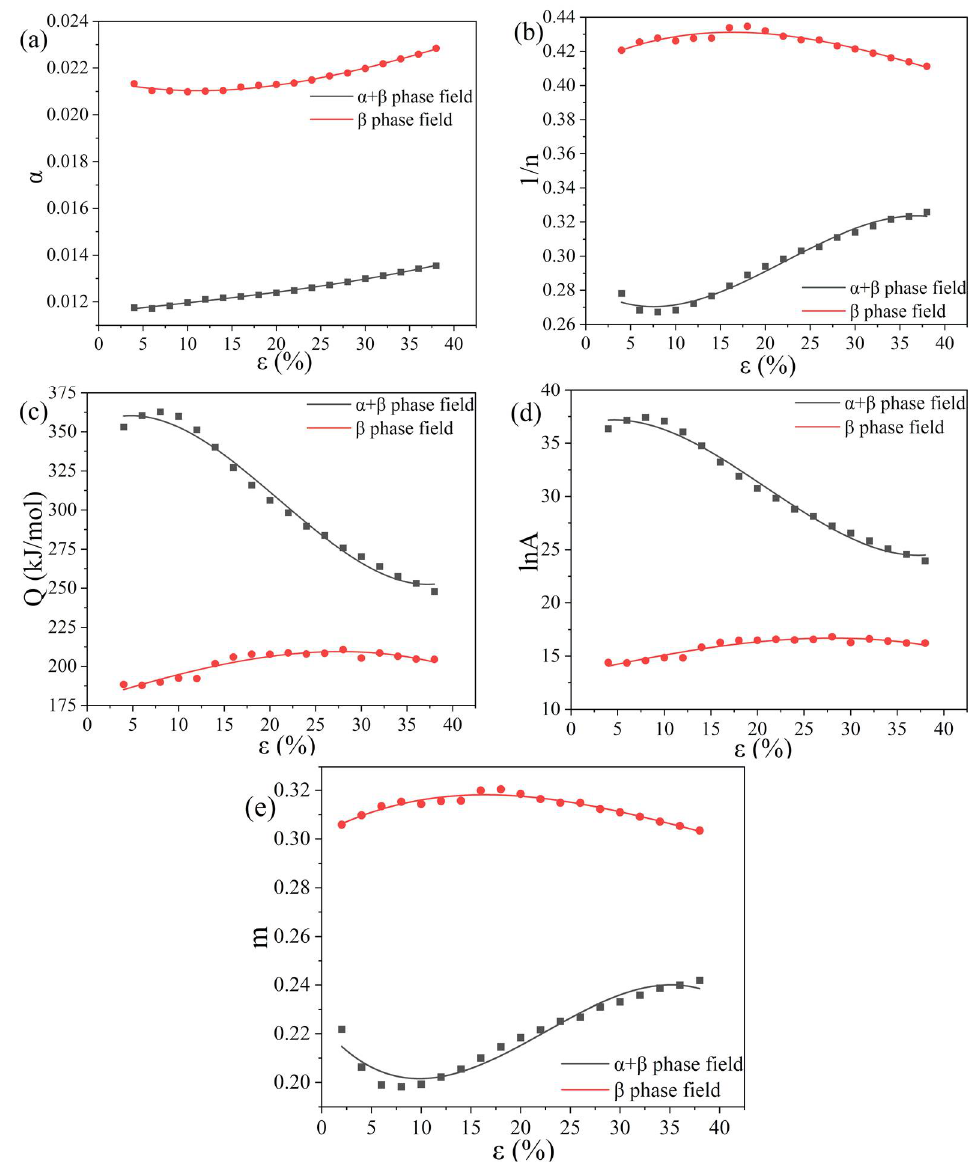
Figure 8. The relationship between various constants and strain: ( a ) ε-α diagram, ( b ) ε -1/ n diagram, ( c ) ε-Q diagram, ( d ) ε- ln A diagram, and ( e ) ε-m diagram. Table 8. Third-order polynomial fitting results of parameters with strain for β phase